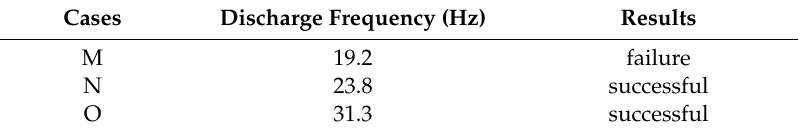
Table 3. Combustor ignition ability under di ff erent discharge frequencies.